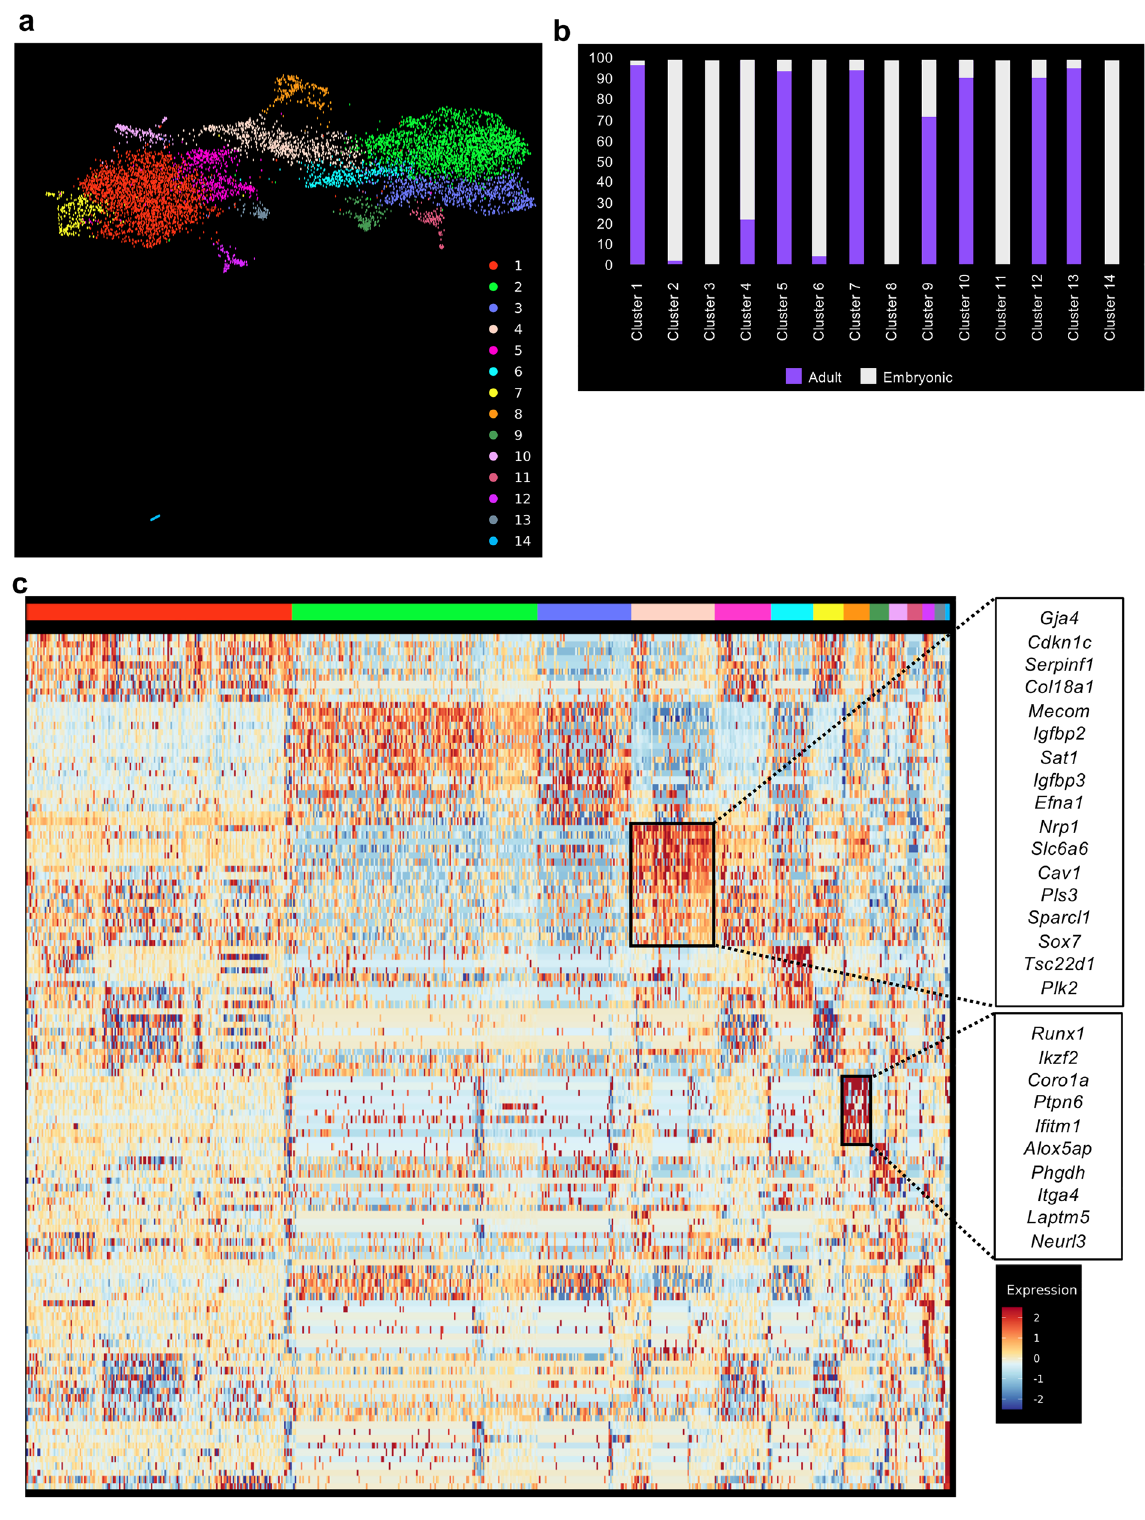
Figure 2. sc-RNA-seq analysis showed a partial similarity between embryonic and adult endothelial cells. ( a ) UMAP plot showing the clustering analysis result following integration of embryonic and adult tissues; ( b ) Bar plot indicating the cellular composition of each cluster identified in ( a ). ( c ) Heatmap of gene expression highlighting the top 10 marker genes of clusters 4 and 8 from ( a